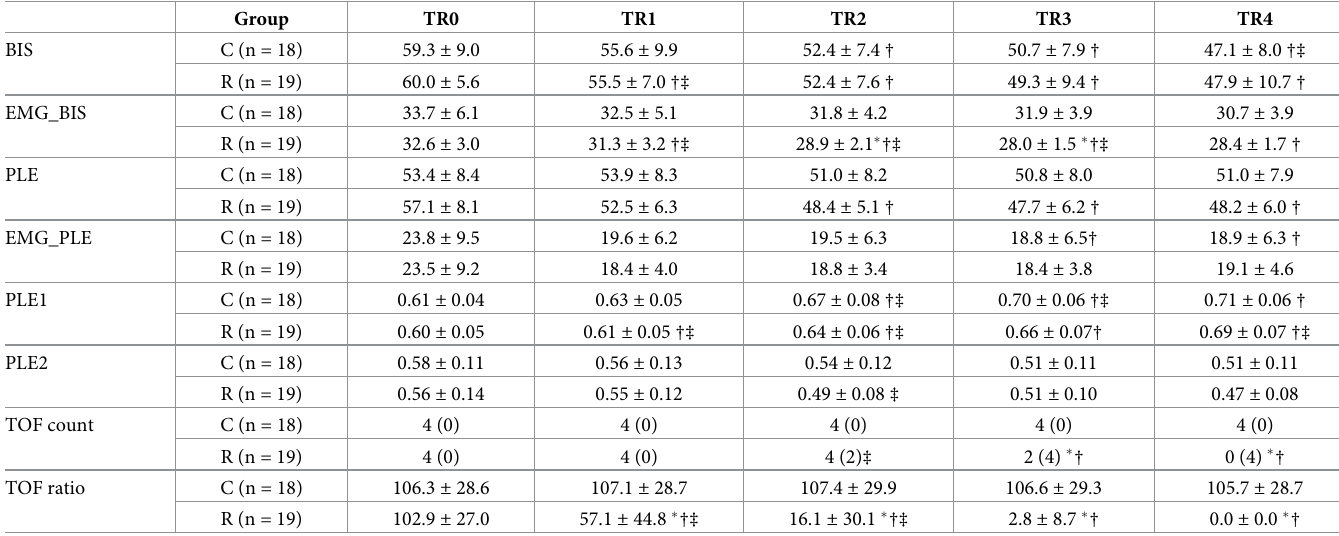
Table 4. Changes in BIS and PLE after administration of study